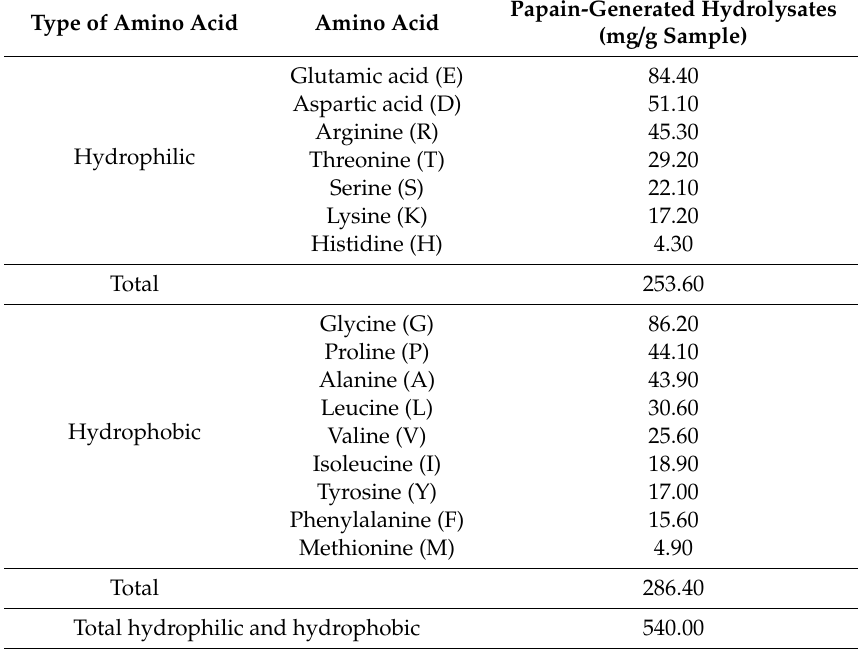
Table 6. Amino acid composition (mg / g dry weight) of optimized papain-generated Actinopyga lecanora